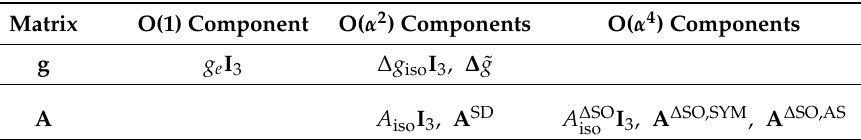
Table 1. Decomposition of the components of the Zeeman and hyperfine coupling matrices by isotropic and anisotropic components, I 3 indicates a 3 × 3 identity matrix.